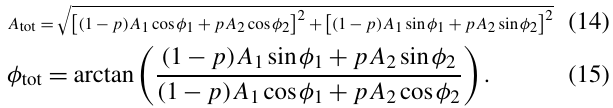
1980). For two reservoirs in parallel we get (see Sect.